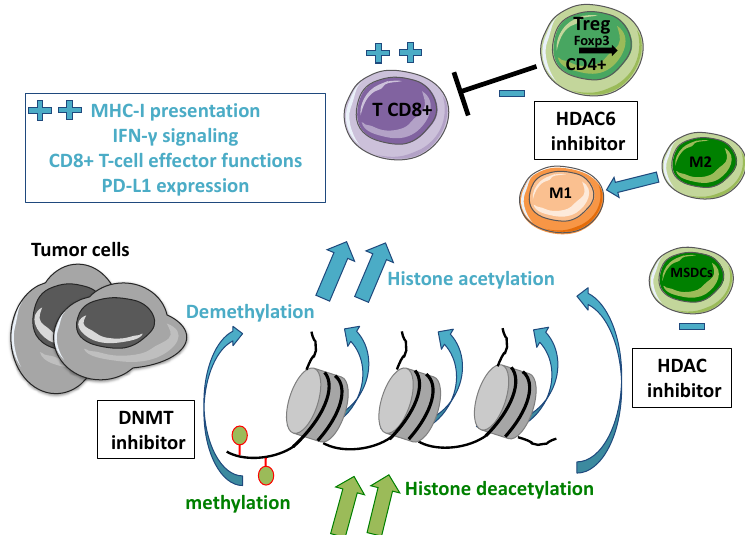
Figure 1. Mechanisms of epidrugs to restore anti-tumor immune response. Several mechanisms targeted by epidrugs to prime anti-tumor immune response are illustrated in this figure. Blue color represents the biological effects induced by HDAC inhibitors or DNMT inhibitors.